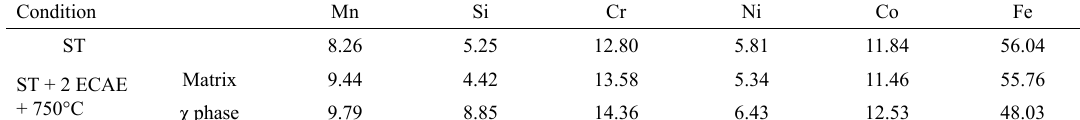
Table 1. Chemical compositions of ST (starting material), austenite matrix and χ phase particles after ST + 2 ECAE + 750°C (in wt %) (TEM-EDS). Condition